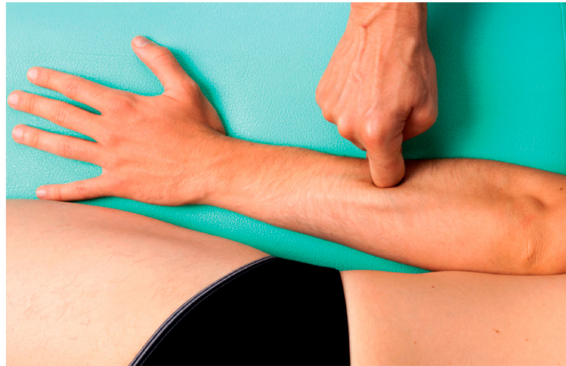
Figure 1. Treatment over the center of coordination ER-CA (see Figure